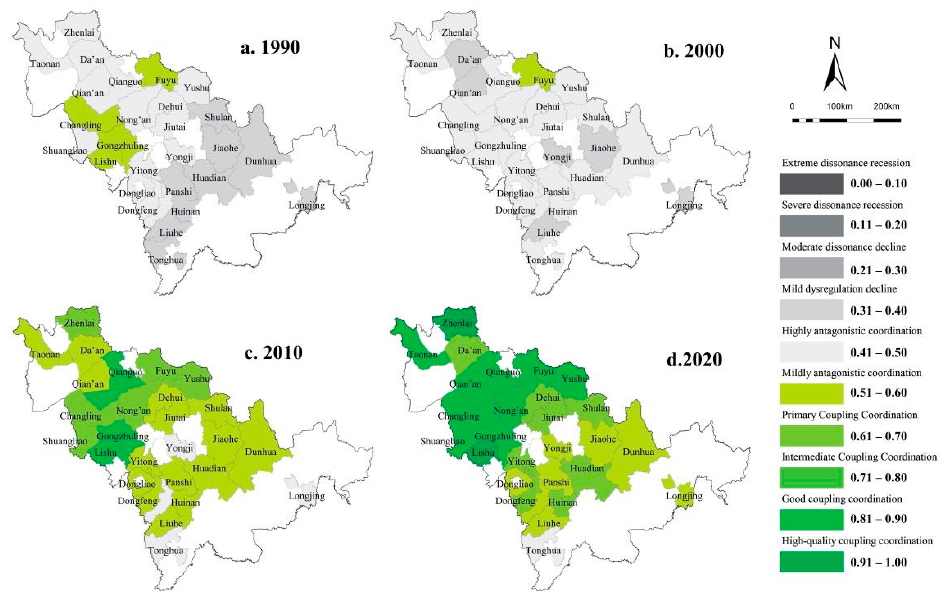
Figure 5. Coupling–coordination among sub-functions of cultivated land in the black-soil breadbas- kets of Jilin Province, Northeast China, from 1990 to 2020. Data from Wang et al. [40] were used to divide the coupling–coordination degree into 10 types.